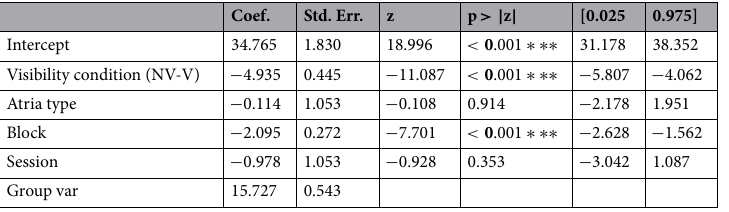
Table 1. Results of the ‘ Time to Escalator ’ linear mixed effects model regression (LEMR), TimeToEscalator ∼ AtriaType + Block + VisibilityCondition + Session + ( 1 | Participant ) , we denote p-values satisfying the Bonferroni corrected alpha with ***.